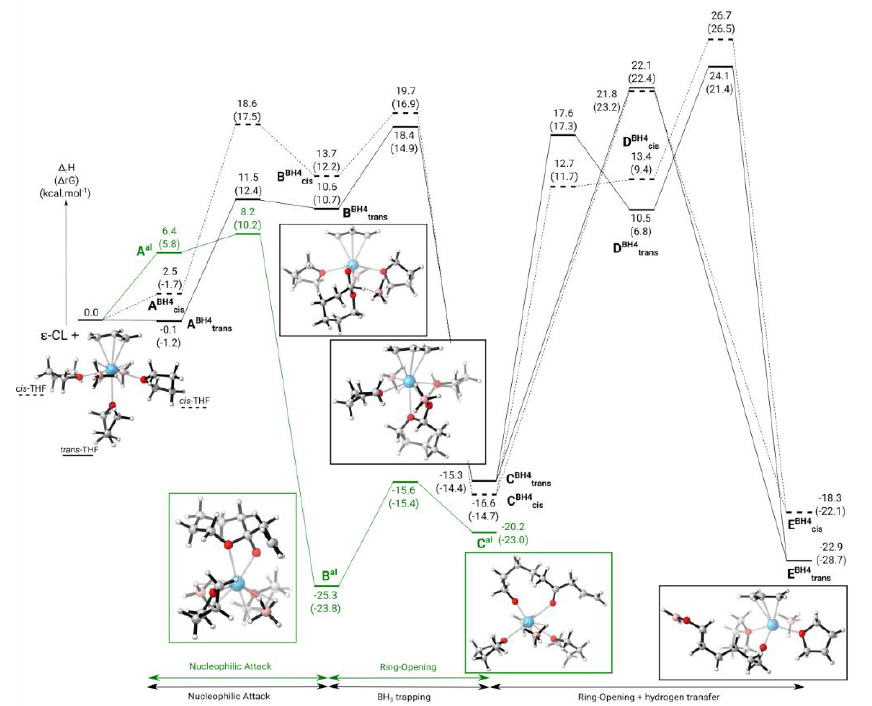
Figure 1. Calculated enthalpy profiles of the initiation step in the ROP of ε-CL mediated by the allyl group (green lines) or the borohydride group (black lines) of La(BH 4 ) 2 (C 3 H 5 )(THF) 3 . Black dotted lines: one of the THF molecules in the cis position to the allyl group is replaced by ε-CL. Black solid lines: the THF molecule in the trans position to the allyl group is replaced by ε-CL.